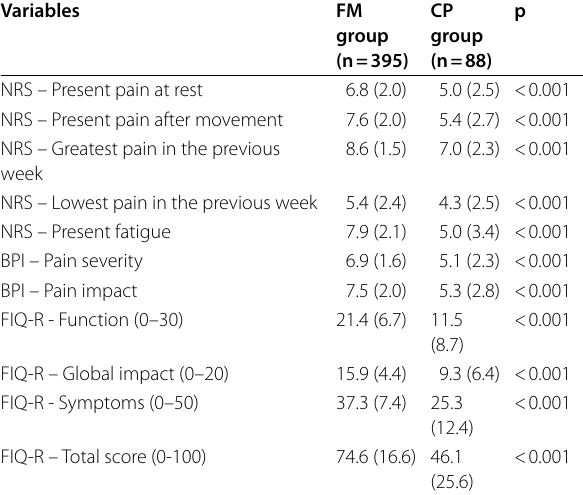
Table 2 Questionnaires’ scores for the participants of both groups, presented as mean (standard deviation) Variables